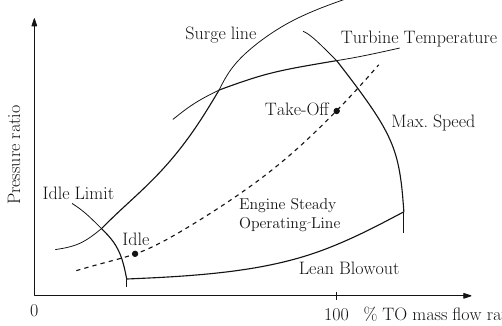
Fig. 1.9 Engine line and operating limits on compressor map Figure 3. Engine line and operating limits on compressor map